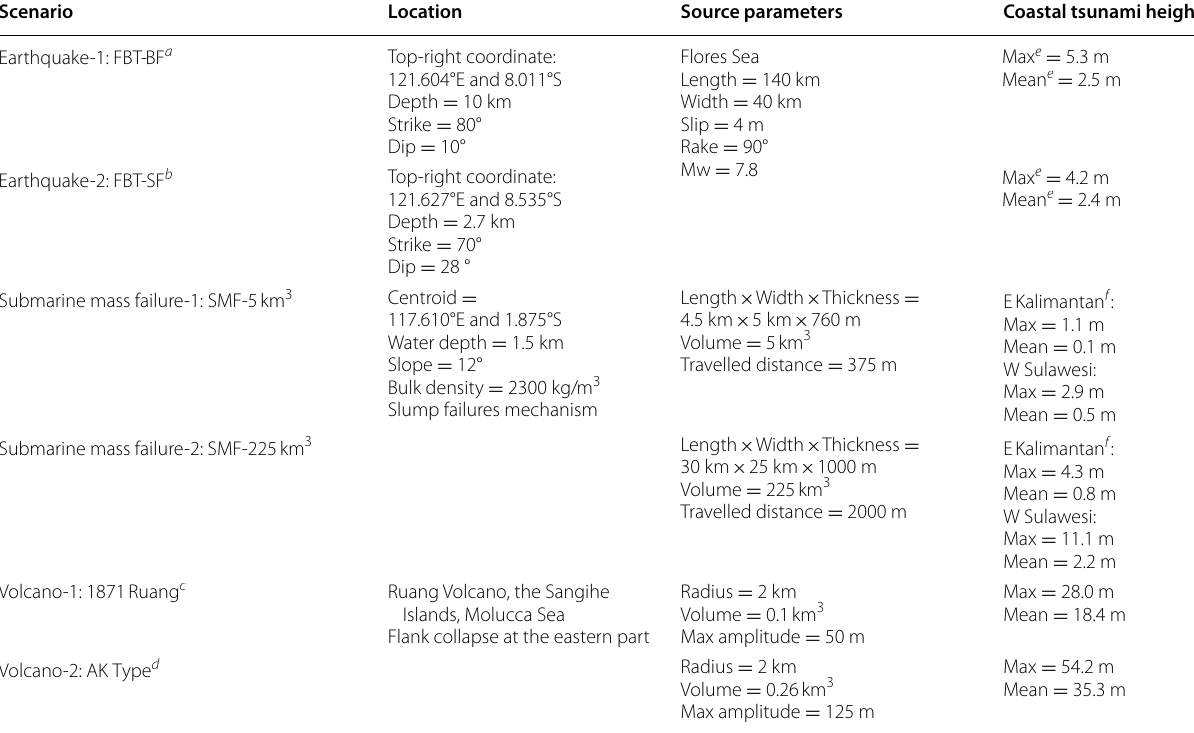
Table 1 Tsunami scenarios of earthquake, submarine mass failure, and volcano origins in eastern Indonesia